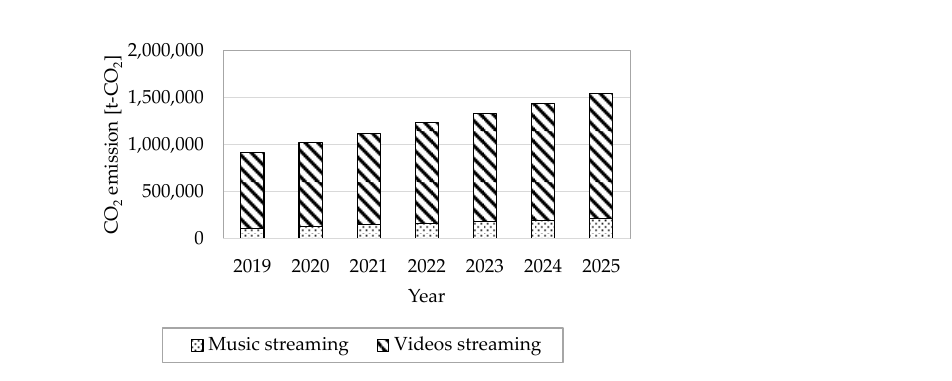
Figure 2. Future projection of CO 2 emission derived from music and videos streaming in Japan.